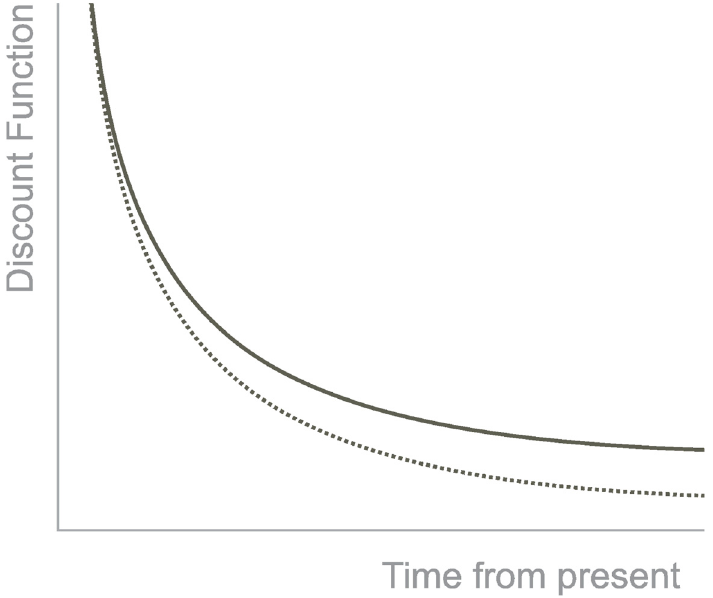
Figure 1. Hyperbolic Discounting. Note. The discounting of the outcome has a hyperbolic shape in function of time. The continuous line represents the hyperbolic function, and the dotted line an exponential function.